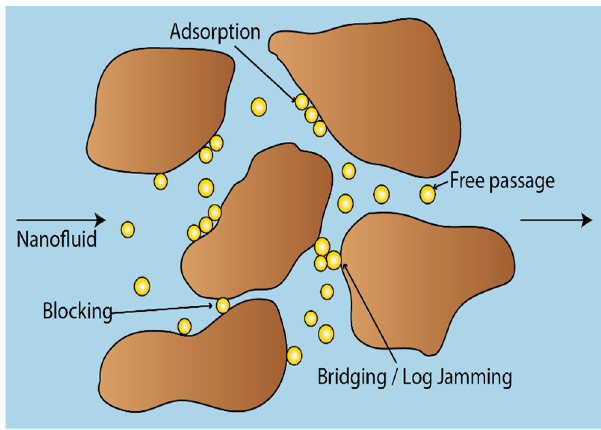
Figure 3. Possible transport outcomes for nanoparticles flowing through porous media.